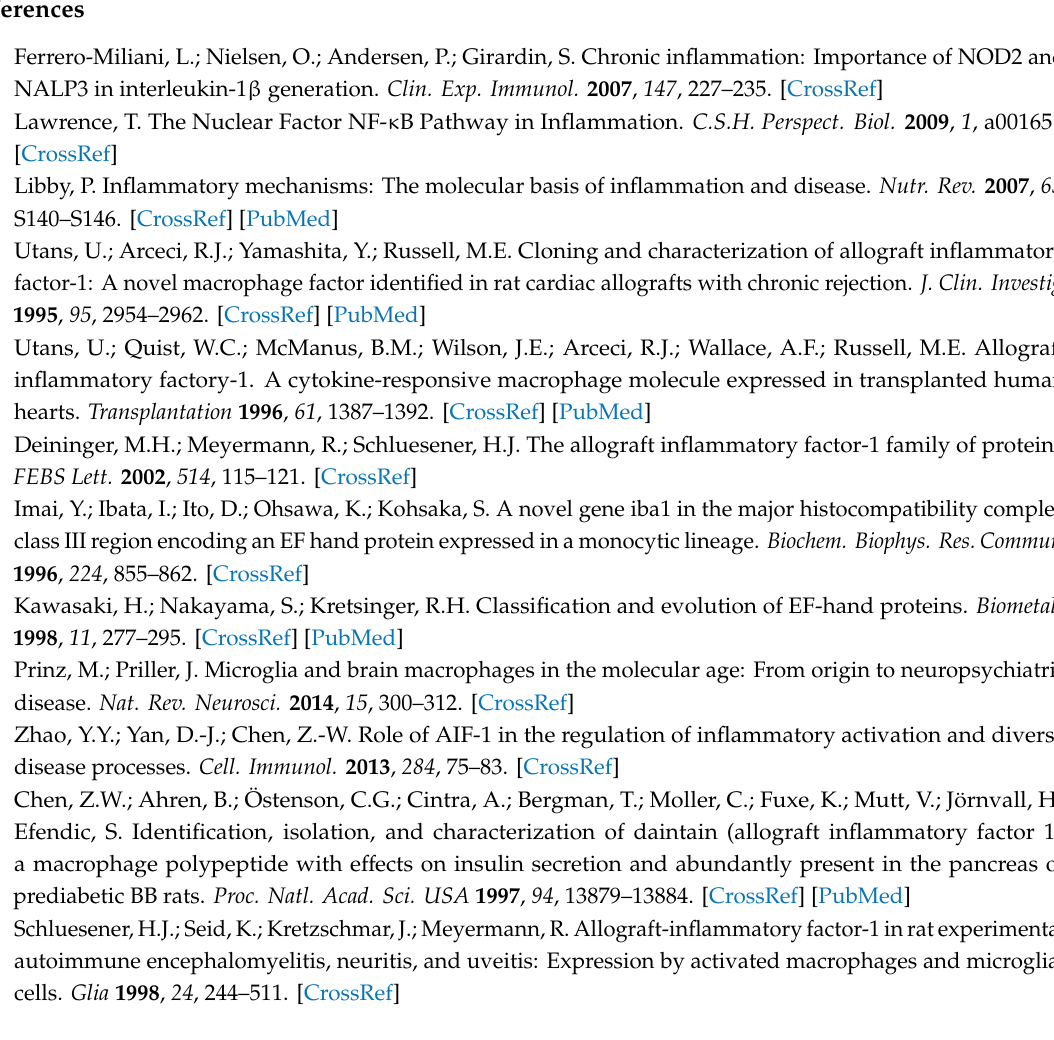
Figure S1: Percent Identity Matrix (upper panel) created by Clustal Omega alignment (lower panel). Amino acid sequence alignment of metazoan AIF-1. Multiple sequence alignment was generated using Clustal Omega at https: // www.ebi.ac.uk / Tools / msa / clustalo / using default